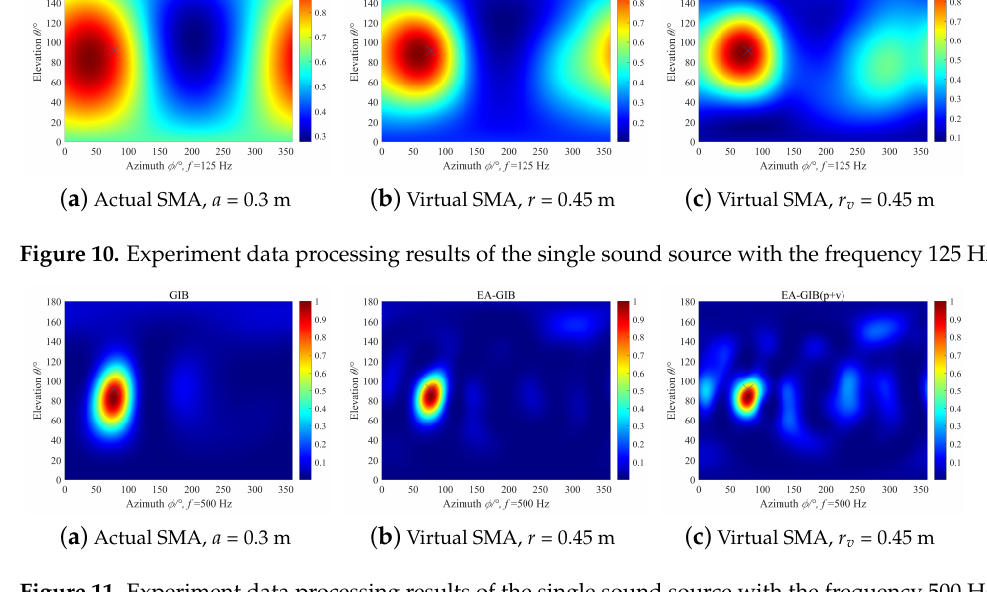
Figure 11. Experiment data processing results of the single sound source with the frequency 500 Hz.